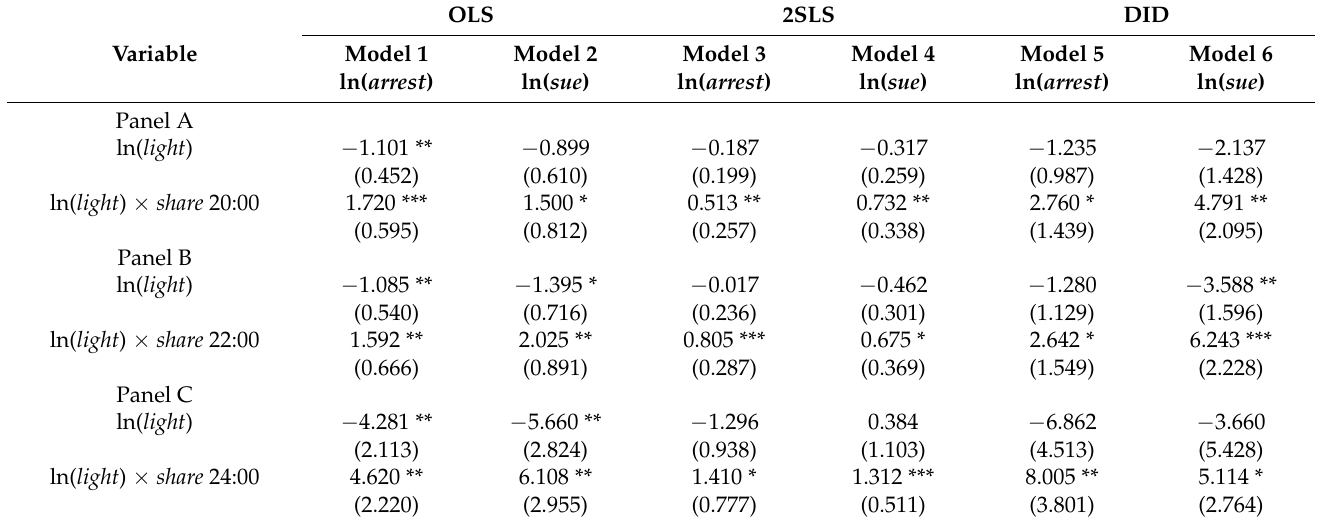
Table 8. Analysis of